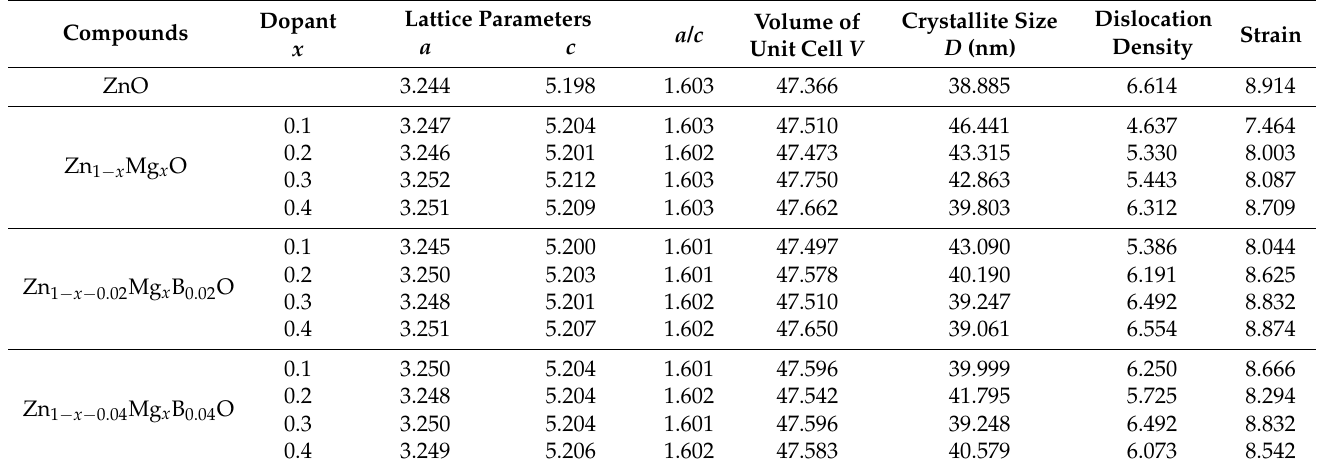
Table 1. Calculated parameters for